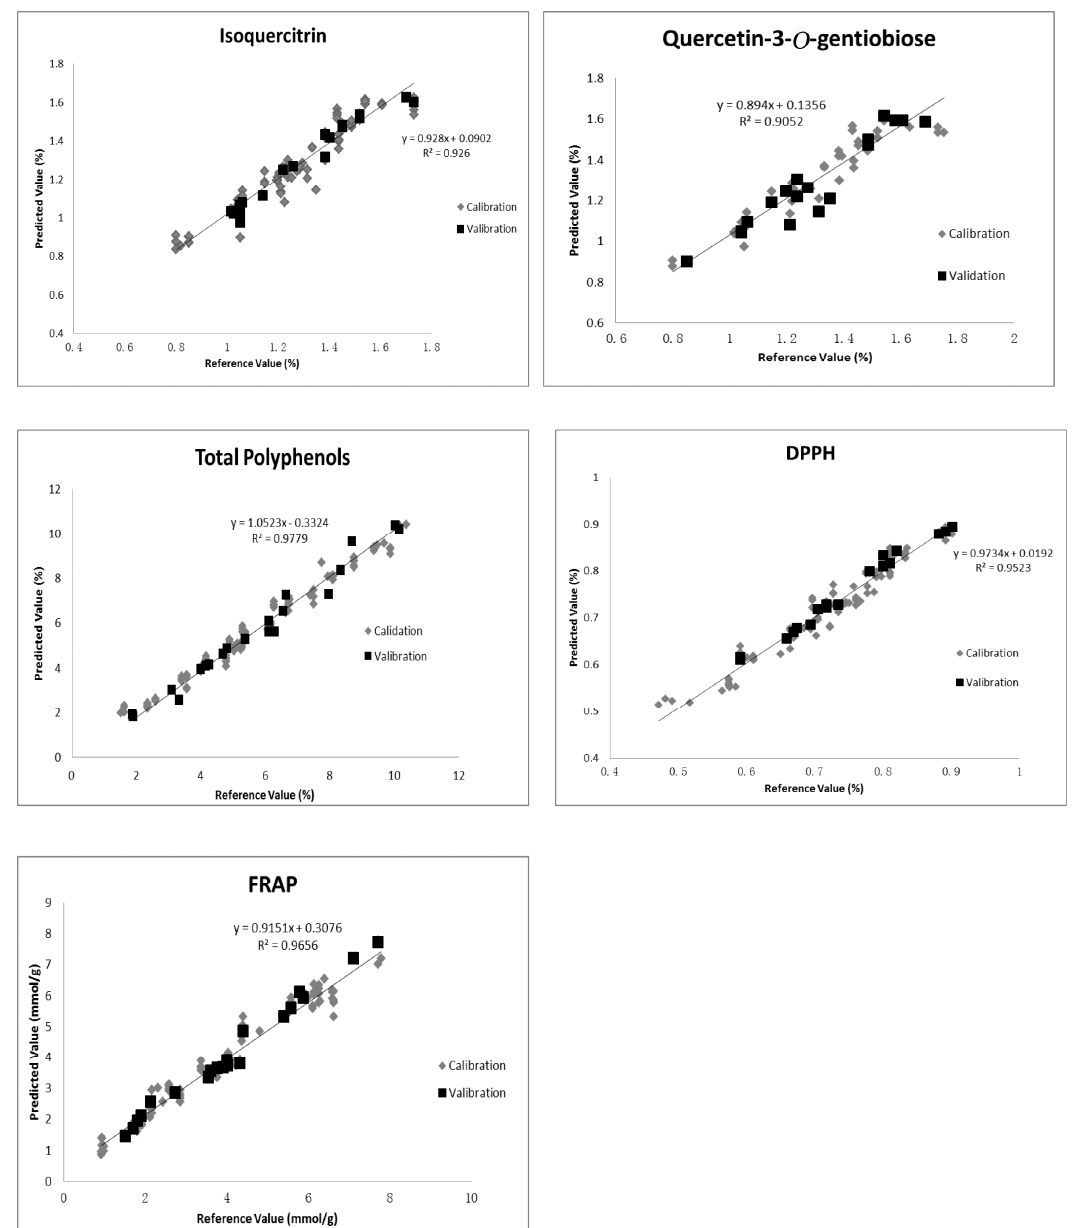
Figure 2. Correlation between reference values and FT-NIR predicted values using PLS for okra